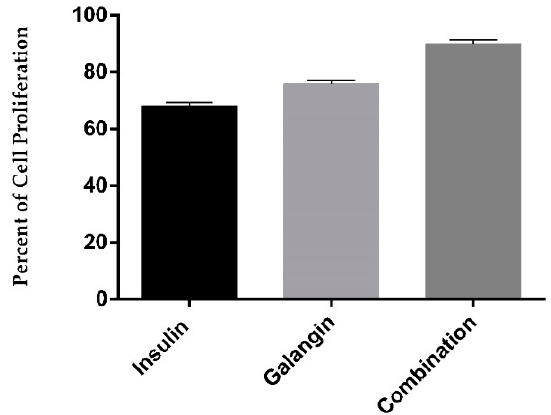
Figure 5. Effect on the percent of cell proliferation on differentiated rat L6 skeletal muscle cells over 24 h with different treatments of 10 nM insulin alone, 270.2 µg/mL galangin alone, and in combination (10 nM insulin and 270.2 µg/mL galangin). All data are represented in the graph as the mean ± standard deviation of six different experiments.